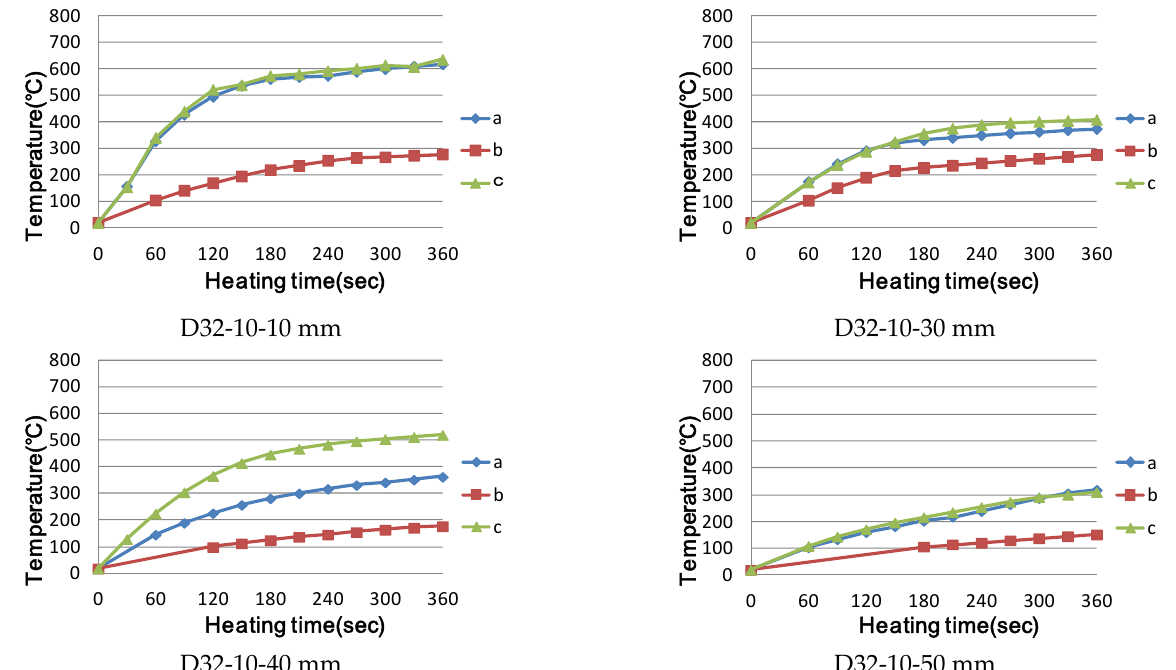
Figure 15. Temperature characteristics of crossed rebar (5 kW).